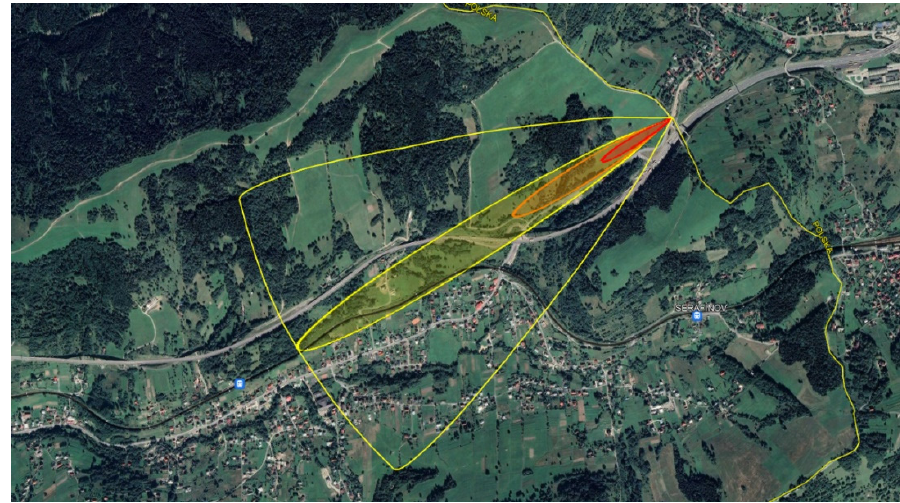
Figure 7. Graphical representation of the dispersion of a dangerous substance at the Skalité-Zwardo ň -Myto 2 border crossing [24,25].